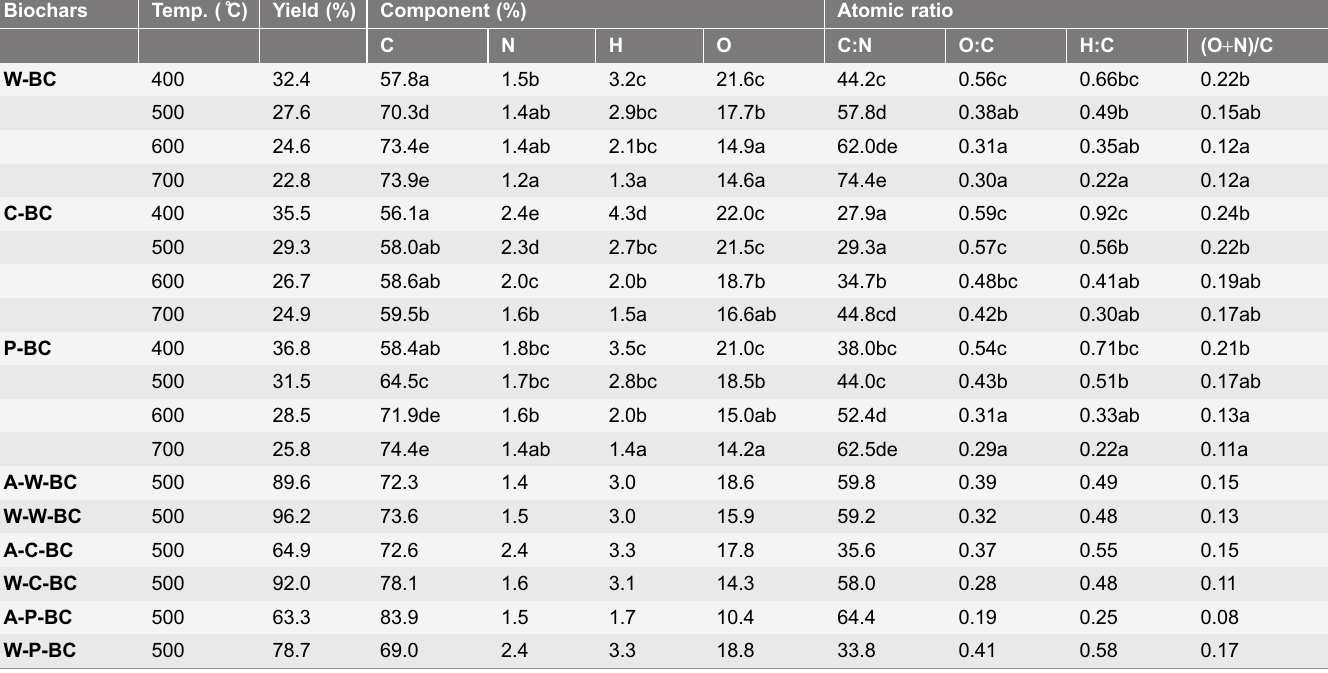
Table 1. The yields, chemical compositions and atomic ratios of biochars produced from different feedstocks at different pyrolytic temperatures. Biochars